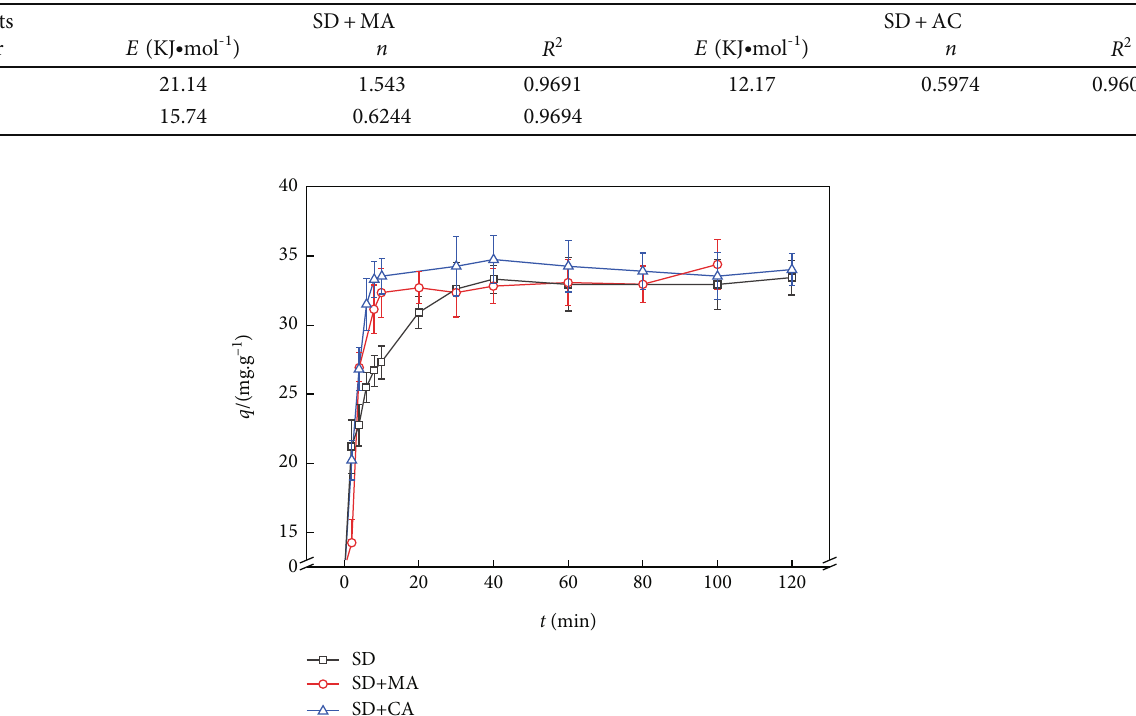
Table 3: Kinetic properties for adsorbents using Freeman-Carroll method.